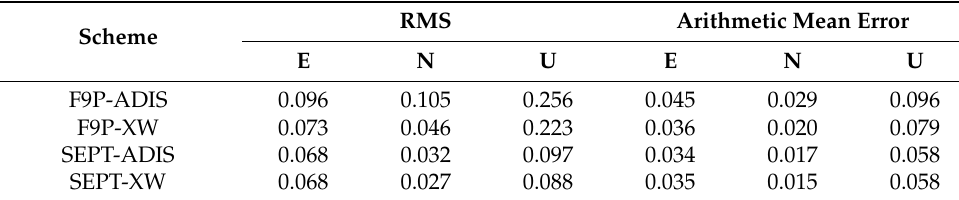
Table 6. RMS and arithmetic mean error of different schemes in experiment C (unit: m). Scheme